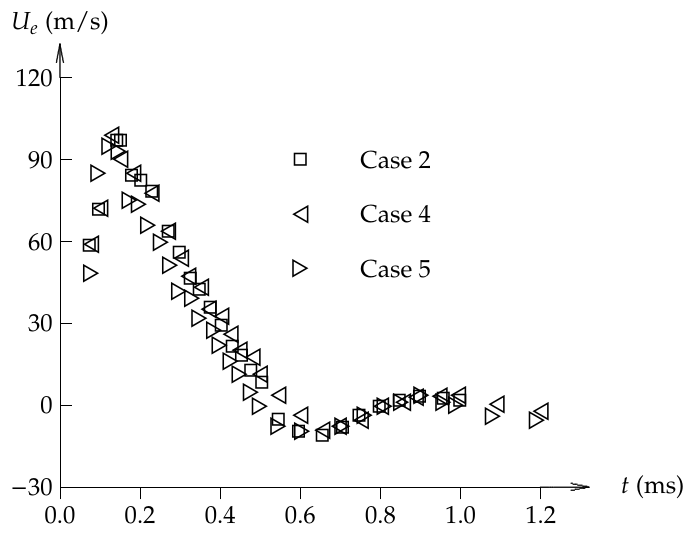
Figure 26. Jet exit velocity versus time at fixed E c .